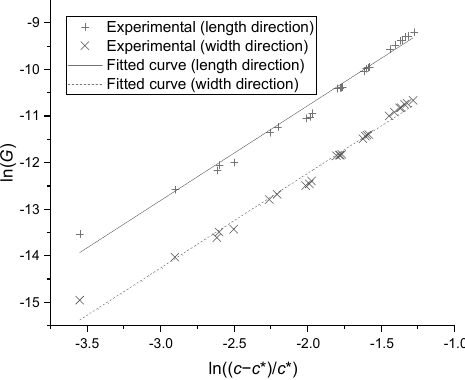
Figure 8. The growth rates versus supersaturations in particle length and width direction.